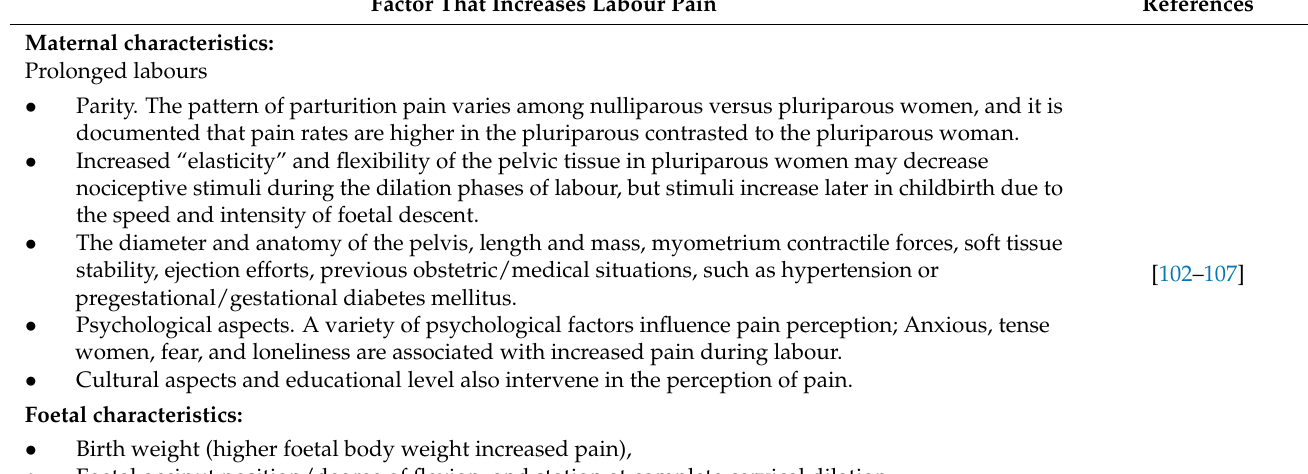
Table 1. Factors associated with dystocia, prolonged labour and pain in women. Factor That Increases Labour